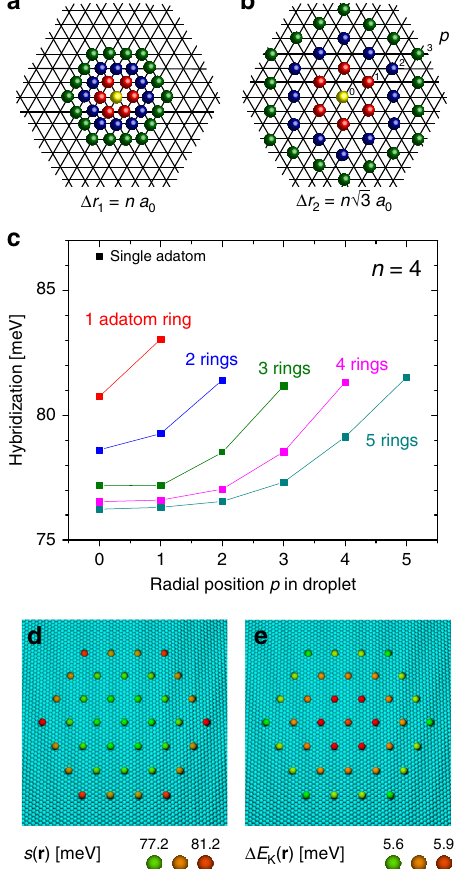
Fig. 2 Spatially dependent Kondo screening within a droplet. Spatial structure of Kondo droplets consisting of three rings of magnetic adatoms ffiffiffi p ¼ na Δ r ¼ na n integer, here shown with distance a Δ r 3 0 and b 0 , with 1 2 for n ¼ 1. For clarity, the rings are shown using different adatom colors. c Hybridization s ð r Þ for different sites in the Kondo droplet shown in b with ffiffiffi p Δ r ¼ 4 a 3 0 with increasing number of rings of magnetic adatoms. Spatial 2 ð r Þ for a Kondo droplet with three rings of structure of d s ð r Þ and e Δ E ffiffiffi p K ¼ 4 a adatoms and Δ r 3 0 2